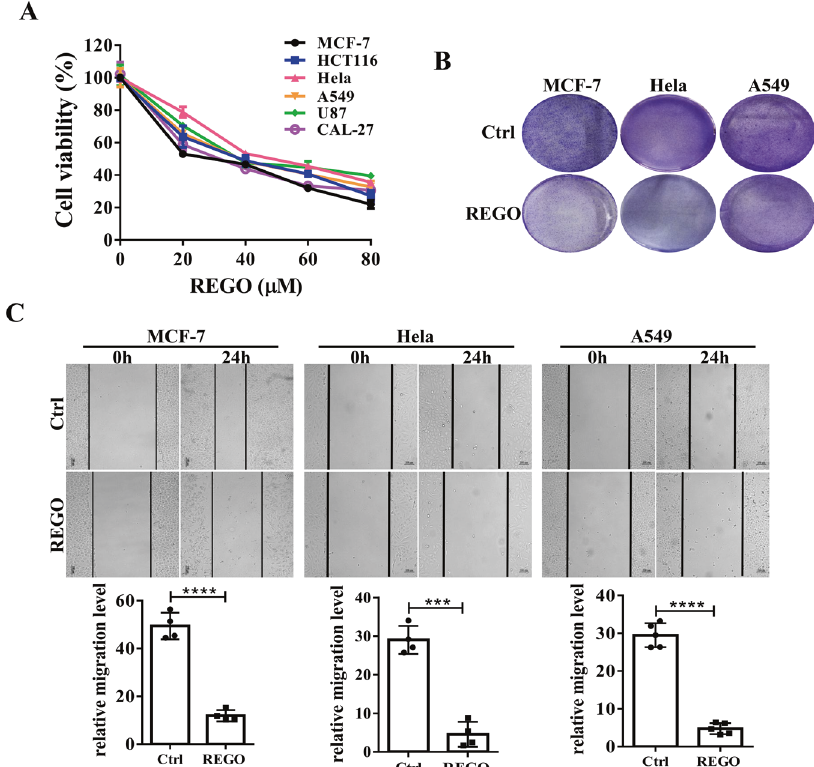
Fig. 1 REGO inhibits cell proliferation and migration in human cancer cells. A REGO induced dose-dependent cytotoxicity in six tumor cell lines measured by CCK-8 assay. B The ability of REGO-inhibited proliferation of MCF-7, Hela and A549 cells assessed by cell colony formation assay. C The ability of REGO-induced MCF-7, Hela and A549 cells migratory capability evaluated by the wound healing assays. Representative images of MCF-7, Hela and A549 cells are shown as photomicrographs (×100). *** p < 0.001, **** p < 0.0001. All data are expressed with the mean ± SD of three independent